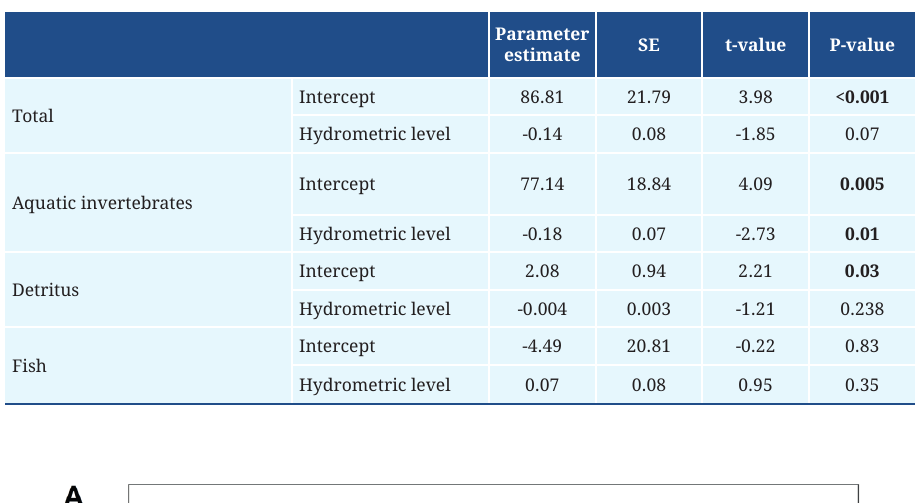
TABLE 2 | Results generalized linear mixed model analysis between the consumption of autochthonous items by Trachelyopterus galeatus in the function of the hydrometric level of the floodplain. P-values < 0.05 are in bold. SE = Standard Error.